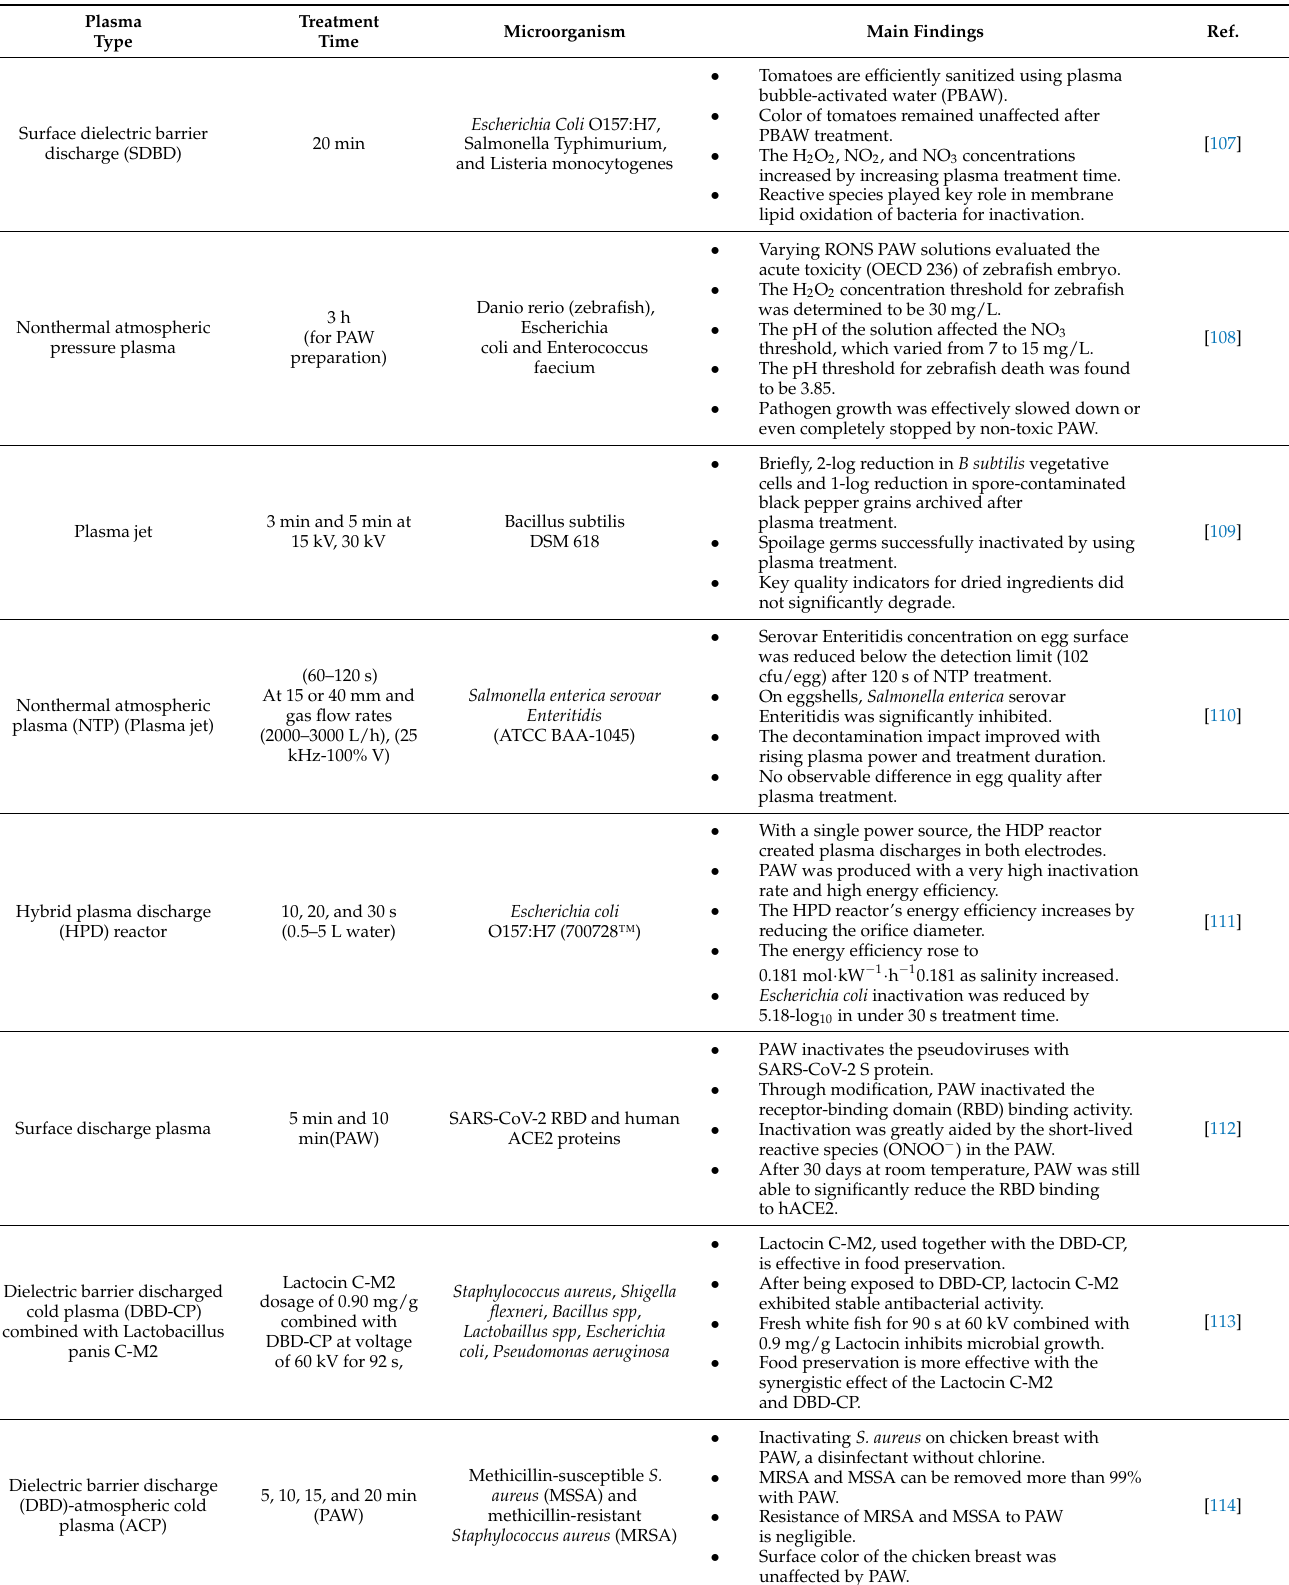
Table 2. Summary of recent NTP advancements for applications in food preservation and bacterial